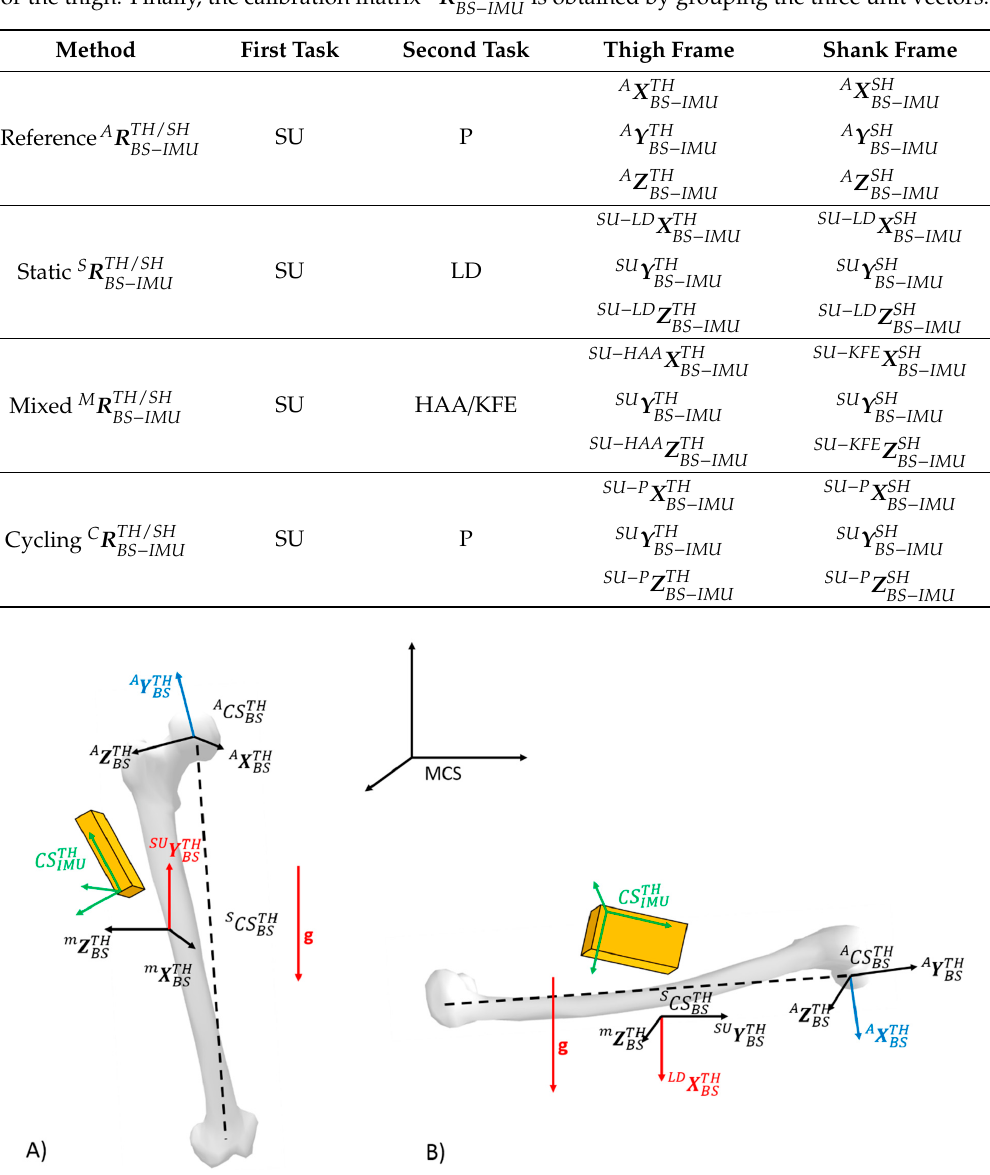
Table 2. Definition of the calibration methods—expressed as rotation matrices—by means of task combinations. For example, for the cycling method, the unit vector SU − CY X TH is obtained from BS − IMU the SU task and cycling task, and it defines the X -axis of the body segment frame for the thigh; the unit vector SU − CY Z TH defines the Z -axis of the body segment frame for the thigh; the unit vector BS − IMU SU Y TH is obtained from the standing up posture and it defines the Y -axis of the body segment frame BS − IMU for the thigh. Finally, the calibration matrix C R TH / SH is obtained by grouping the three unit vectors. BS − IMU